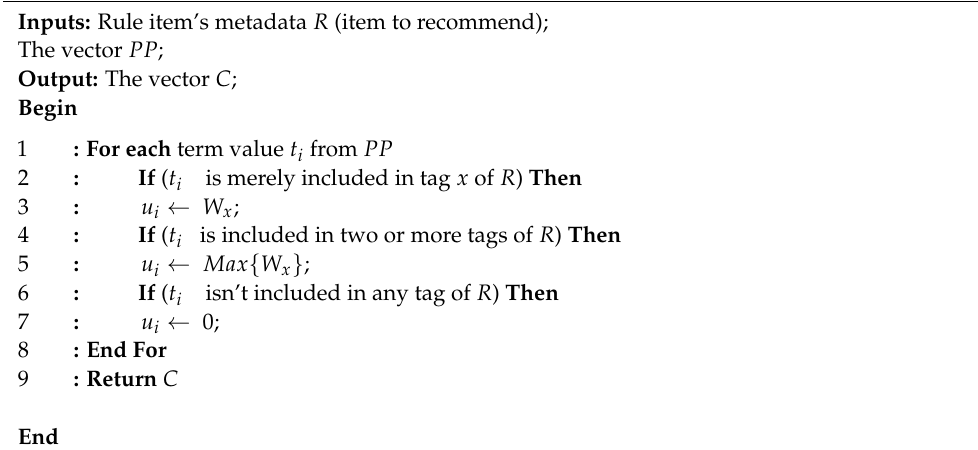
Algorithm 3: Generating the Vector